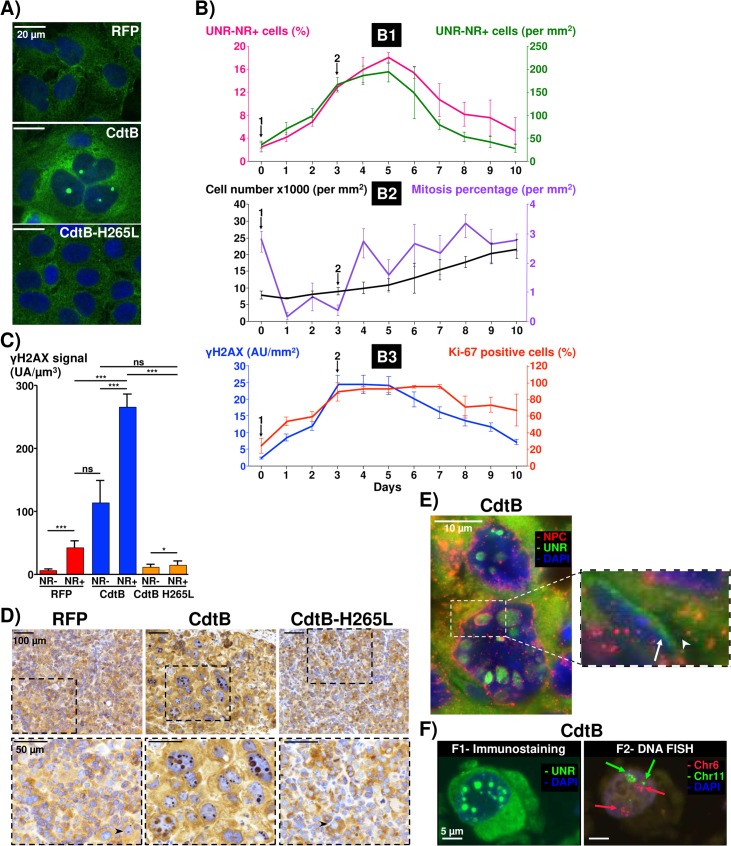
In vitro effects of the CdtB subunit on the localization of UNR protein in liver transgenic cell lines.(A) Images of hepatic Hep3B transgenic cells expressing the control Red Fluorescent Protein (RFP), the CdtB of H. hepaticus strain 3B1 (CdtB) or the CdtB of H. hepaticus strain 3B1 with the H265L mutation (CdtB-H265L). Cells were stained with fluorescent primary and secondary antibodies targeting UNR (green) and DAPI to counterstain the nucleus (blue). (B) Hep3B transgenic cells were cultivated with doxycycline for 72 h (arrow 1). Then doxycycline was removed and new medium was added (arrow 2). Quantification of UNR-NR-positive cells was performed daily until 10 days. (B1) The percentage of UNR-NR-positive cells was determined, as well as the number of UNR-NR-positive cells per mm2. (B2) The number of cells per mm2 and the percentage of mitotic cells was also determined. (B3) γH2AX foci intensity and the percentage of Ki-67-positive cells were quantified. Data represent the mean of triplicates in 1 representative experiment out of 3. (C) Hep3B transgenic cells were cultivated with doxycycline for 72 h. Cells were stained with fluorescent primary and secondary antibodies targeting γH2AX and UNR, and DAPI to counterstain the nucleus. Quantification of γH2AX foci intensity in UNR-NR-positive and -negative nuclei was performed. At least 200 cells were counted for each experiment. Data represent the mean of triplicates in 1 representative experiment out of 3. * p<0.05 and *** p<0.001. (D) Images of 3 μm-tissue sections of Hep3B-CdtB-derived mice engrafted tumors immunostained for UNR and counterstained with standard hematoxylin staining. Arrowhead indicates tiny NR. (E) Images of 3 μm-tissue sections of Hep3B-CdtB-derived mice engrafted tumors stained with fluorescent primary and secondary antibodies: Nuclear Pore Complex Proteins (NPC, red), UNR (green) and DAPI to counterstain the nucleus (blue). Arrowhead and long arrow indicate NPC and the absence of UNR immunostaining within the UNR-rich foci, respectively. (F) Images of 6 μm-tissue sections of Hep3B-CdtB-derived mice engrafted tumors processed for fluorescent staining with primary antibodies to target UNR (green, F1) followed by DNA FISH experiments (F2) with labeled probes hybridizing to the band on the short arm of human chromosome 6 (red) and the long arm of chromosome 11 (green). Images (UNR/DAPI) were captured using the microscope that records the coordinates of each image, which allows repositioning on the same area after DNA FISH assay. Each fluorescent spot corresponds to one copy of the chromosome region. Nuclei were counterstained with DAPI (blue). Red and green arrows in (F2) indicate chromosome 6 and 11 foci, respectively. Fluorescent staining were observed using traditional wide field in (A), (E) and (F). Of note, the visibility of UNR-NR structures in (D) and (E) depends on the cutting orientation of the nucleus section. Magnifications of selected areas are shown in boxes. AU, arbitrary units; CdtB-H265, H. hepaticus CdtB with H265L mutation; CdtB, CdtB of H. hepaticus strain 3B1; Chr, Chromosome; DAPI, 4’,6-diamidino 2-phenylindole; NPC, Nuclear Pore Complex Proteins; ns, non-significant; RFP, red fluorescent protein.